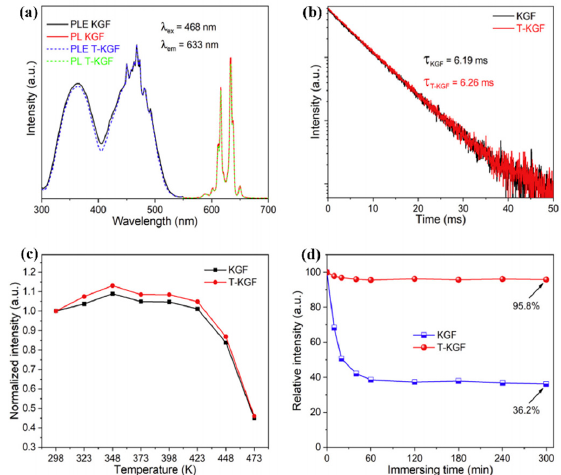
Figure 14. ( a ) Excitation and emission spectra of KGF and T-KGF; ( b ) decay curves KGF and T-KGF; ( c ) temperature-dependent relative PL intensities KGF and T-KGF; ( d ) relative PL intensities of immersion in water for different times of KGF and T-KGF. (Reprinted from Ref [53]. Copyright from Elsevier, 2018).